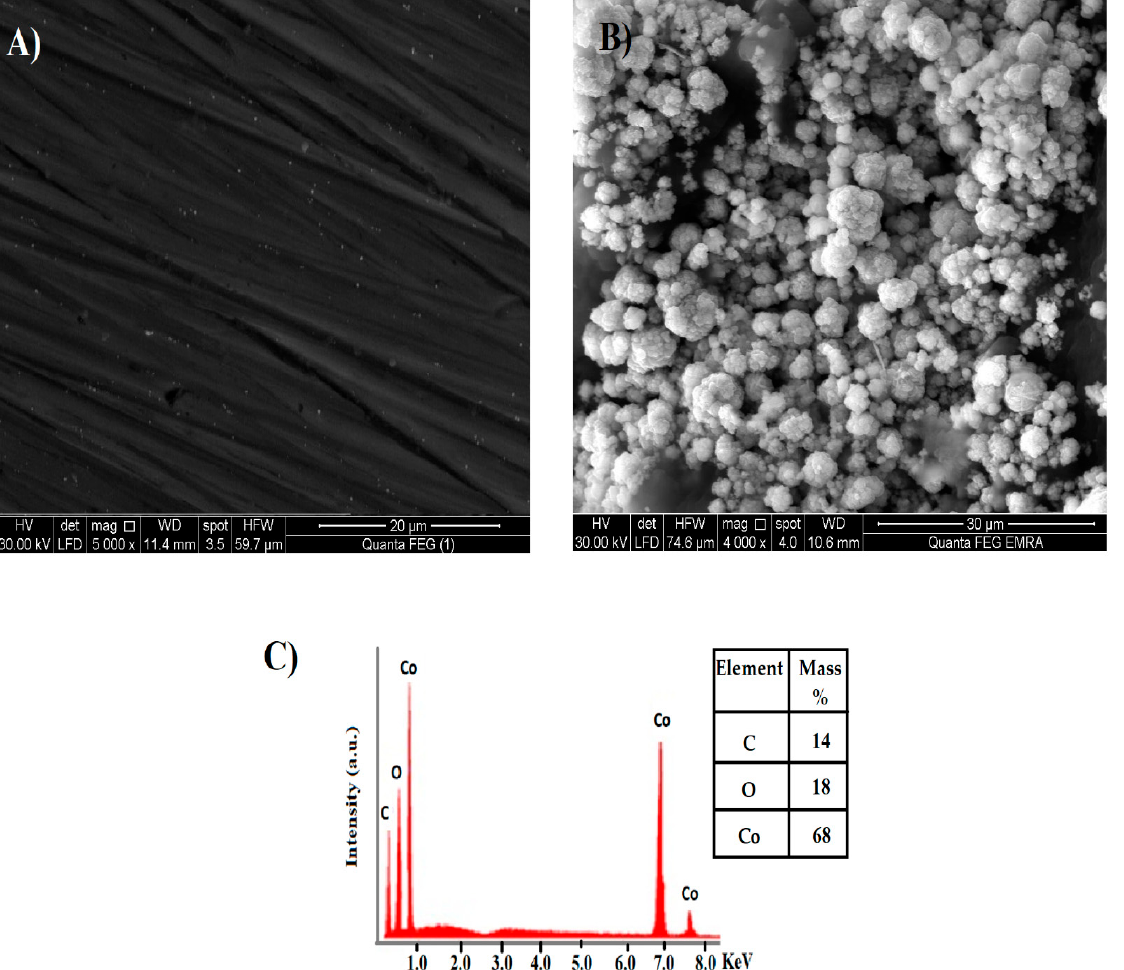
Figure 2. SEM for ( A ) bare Ti alloy and ( B ) Ti alloy/CSNPs/PVP/CoONPs coating, and ( C ) its EDX.